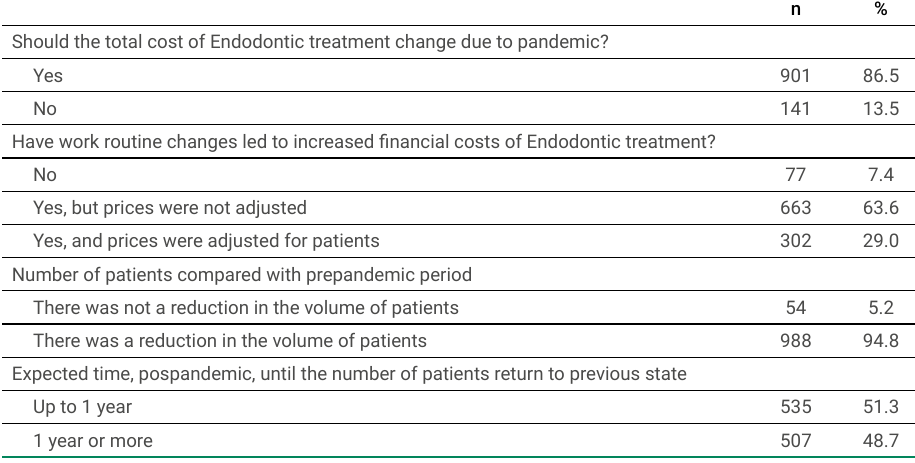
Table 2. Routine changes in Endodontic treatment, volume of patients and economic impact of pandemic